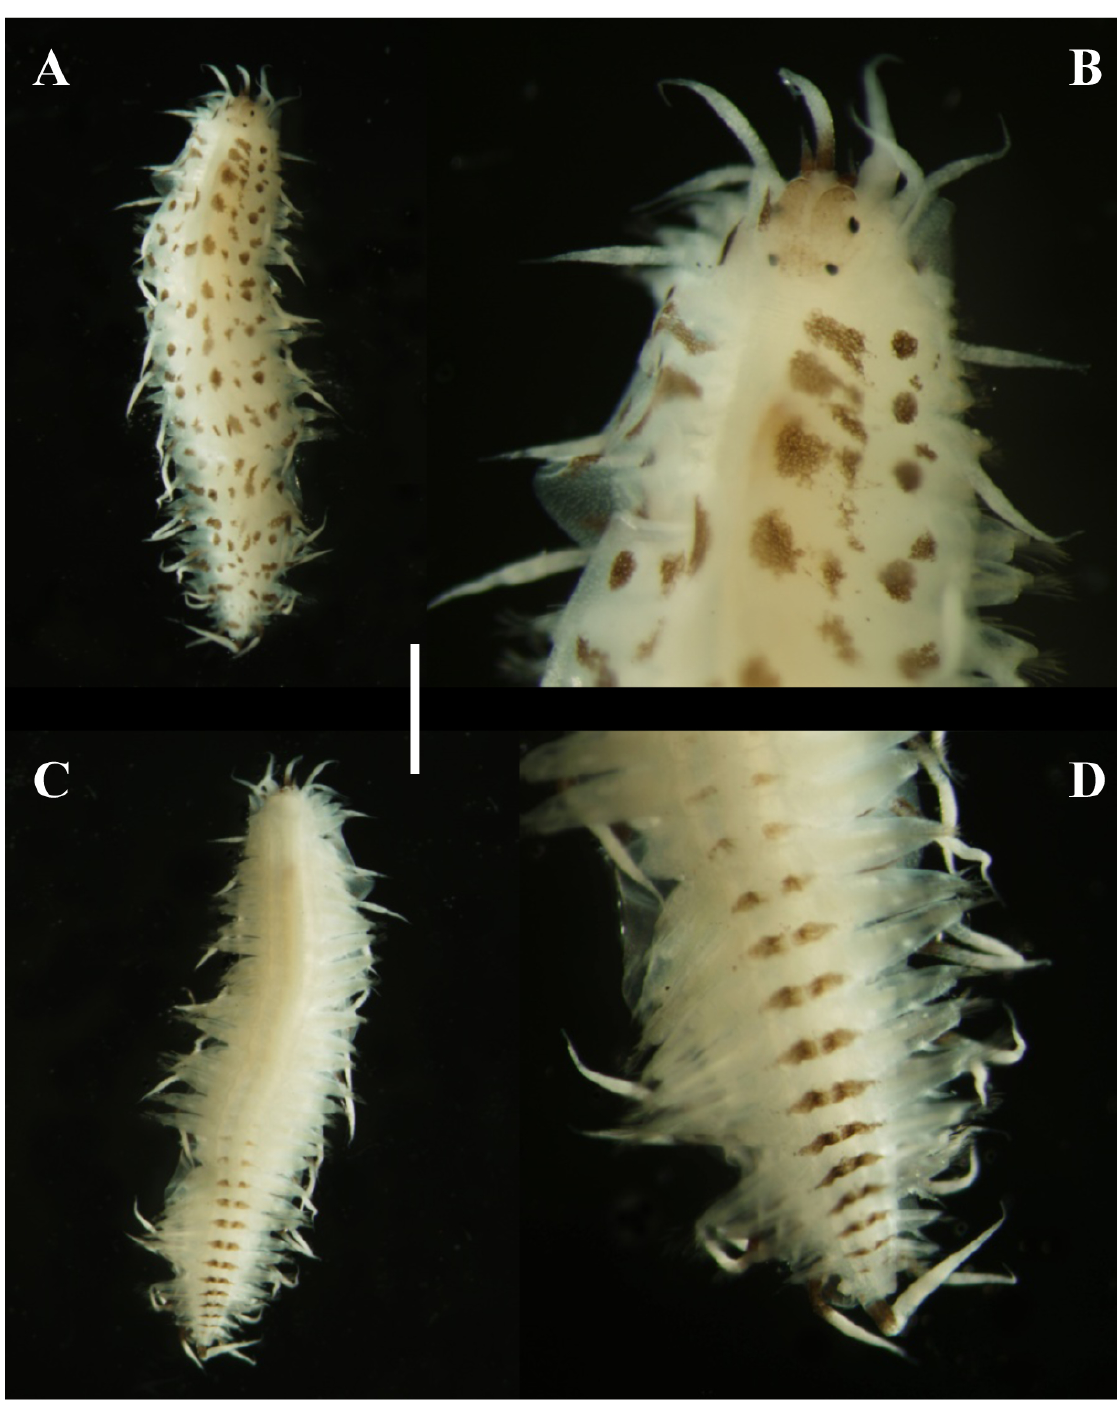
Fig. 3. Webbnesia maculata gen. et sp. nov., holotype (TFMCBM-AN/246). A . Complete specimen, dorsal view. B . Anterior end, dorsal view. C . Complete specimen, ventral view. D . Posterior end, ventral view. Scale bar: A, C = 2 mm; B = 0.6 mm; D = 0.8